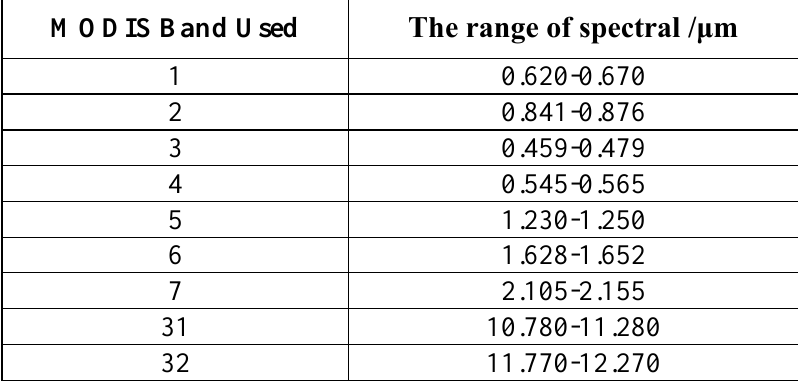
Table 1: Some band settings of MODIS